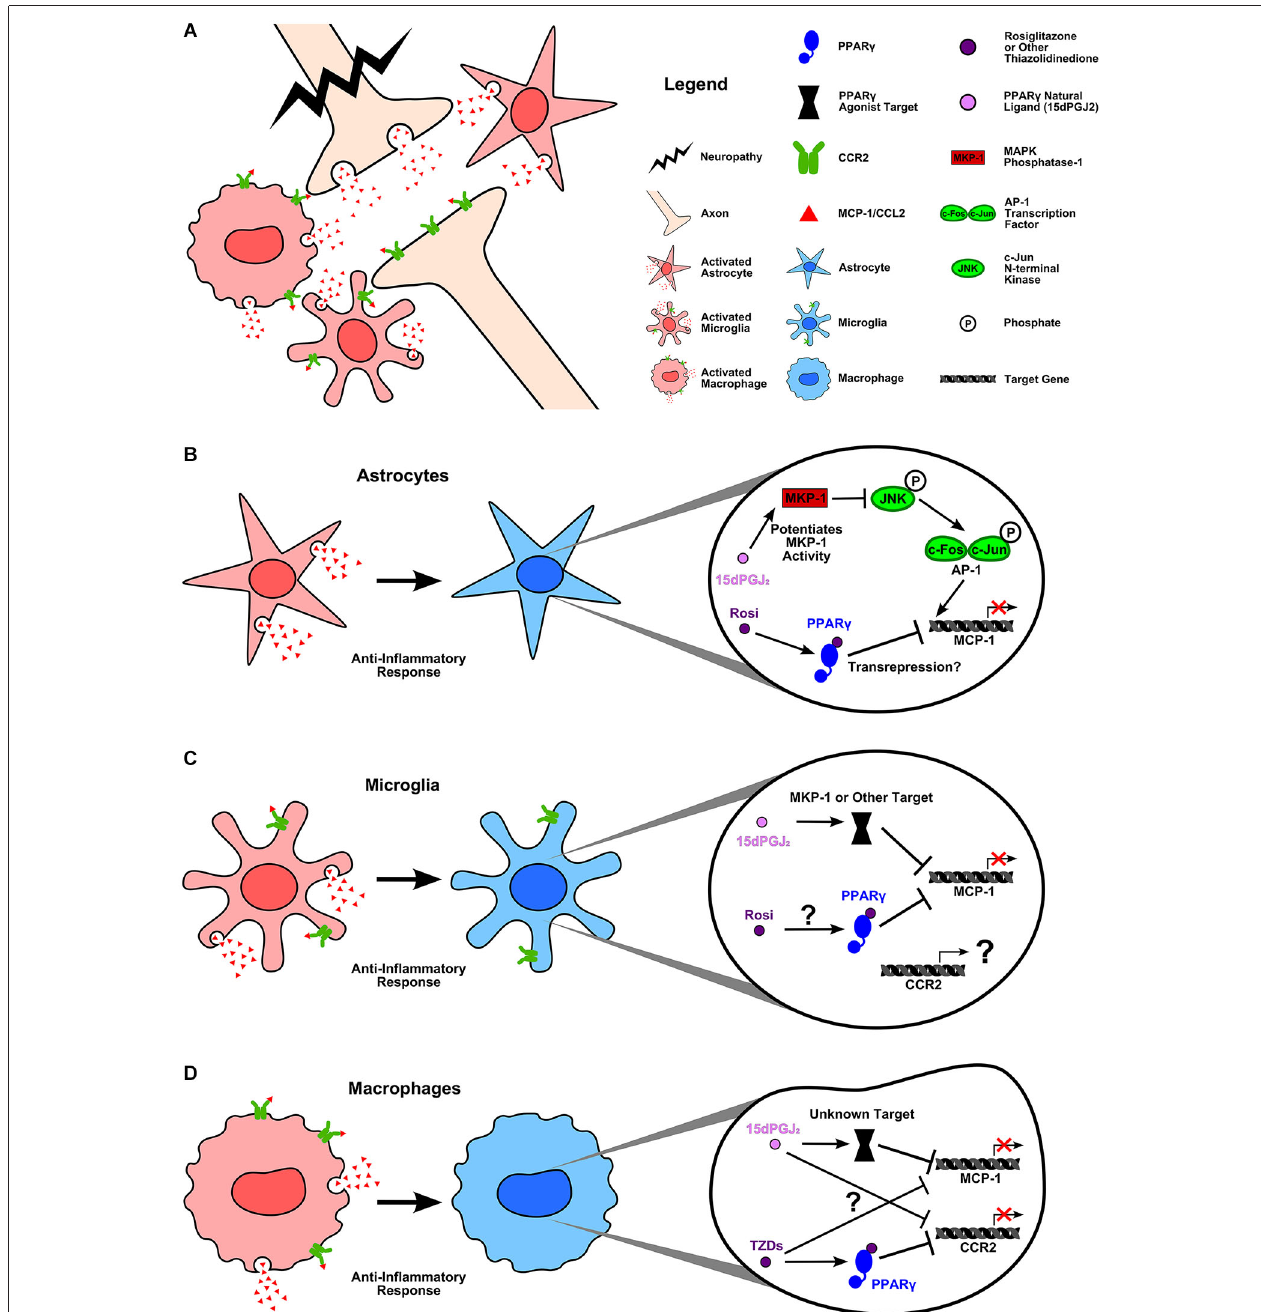
dephosphorylation. This prevents the activation of the AP-1 transcription factor subunit, c-jun, thus inhibiting AP-1 mediated MCP-1 expression. In the case of rosiglitazone, it is unclear what mechanism is used to block MCP-1 expression; however, Lee et al. (2008) confirmed that rosiglitazone acts via PPAR γ to inhibit INF- γ induced MCP-1. (C) Activated microglia upregulate MCP-1 and CCR2 during inflammation. Again, both rosiglitazone and 15d-PGJ 2 can block MCP-1 expression. While rosiglitazone’s mechanism of action remains unclear, studies have verified that 15d-PGJ 2 is acting in a PPAR γ independent manner (Lee et al., 2008; Kim et al., 2012). Lee et al. (2008) reported that, as in astrocytes, 15d-PGJ 2 acts upon MKP-1 to